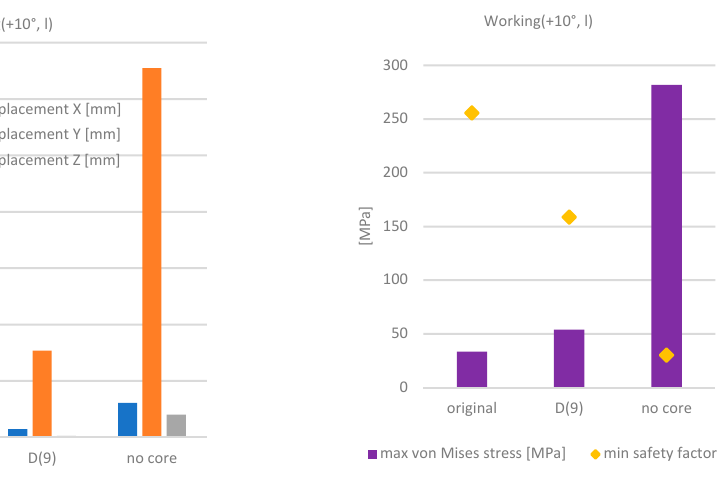
Figure 10. Capsize (clockwise, s ) load case analysis results.